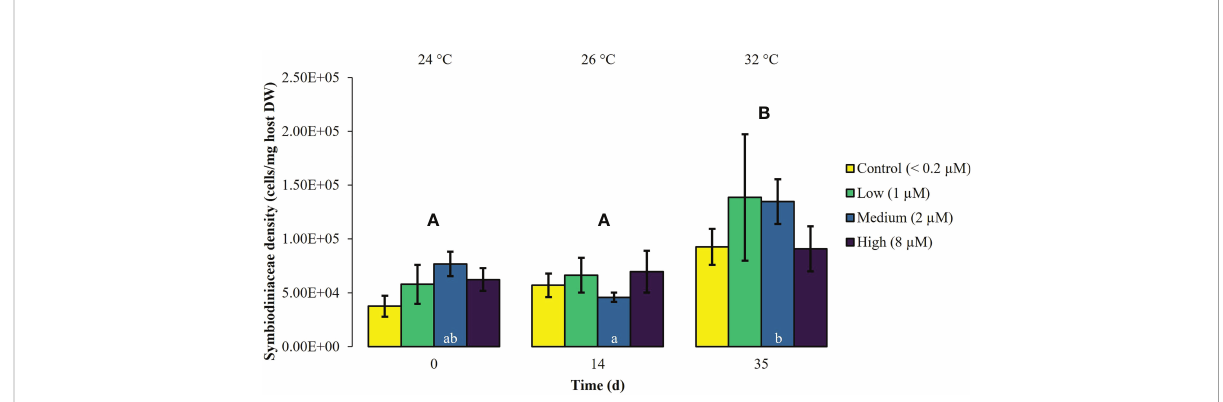
FIGURE 2 Symbiodiniaceae density ± SEM of Xenia umbellata colonies (n = 3) kept at different phosphate concentrations (control < 0.2 m M; low ~ 1 m M; medium ~ 2 m m; high ~ 8 m M) and exposed to an arti fi cially induced water temperature increase. Bars represent the mean of three replicates. Different capital letters above bars indicate signi fi cant differences between days and different letters within bars show signi fi cant differences within treatments over time (pwc, Bonferroni adjustment, t-test, p <